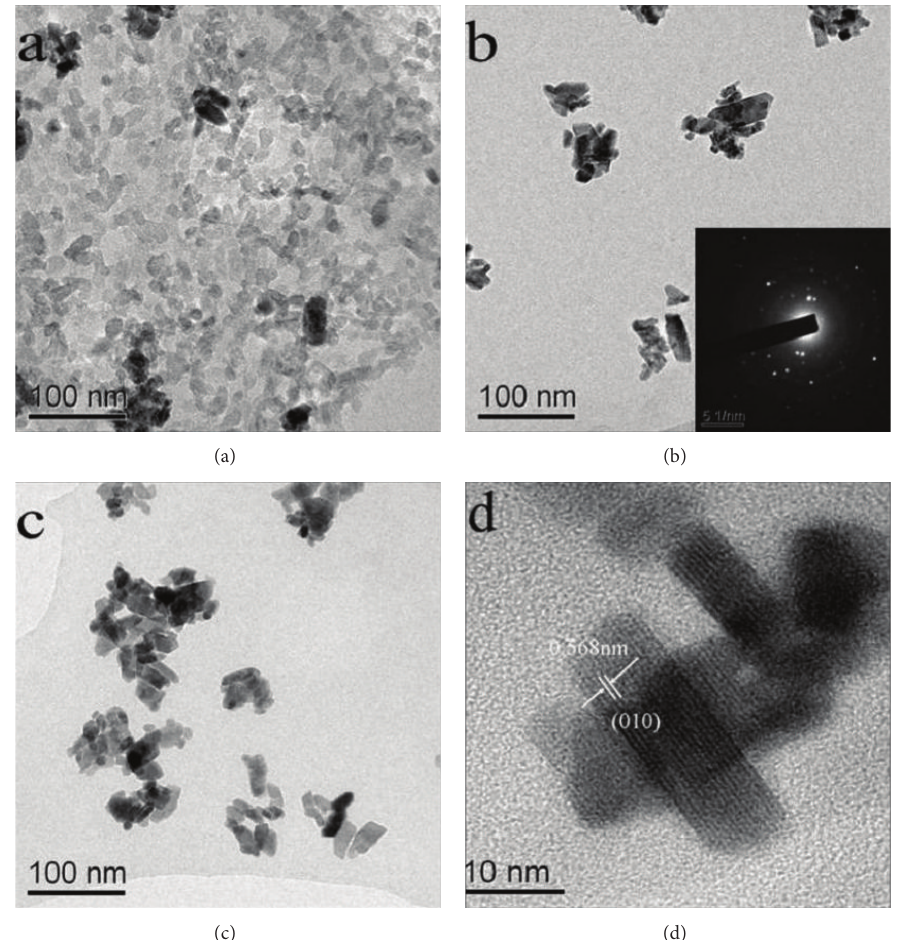
Figure 4: TEM morphologies of ZnWO 4 at 180 ∘ C for different reaction times, 5 min (a), 10min (b), 15min (c), and HRTEM (d).